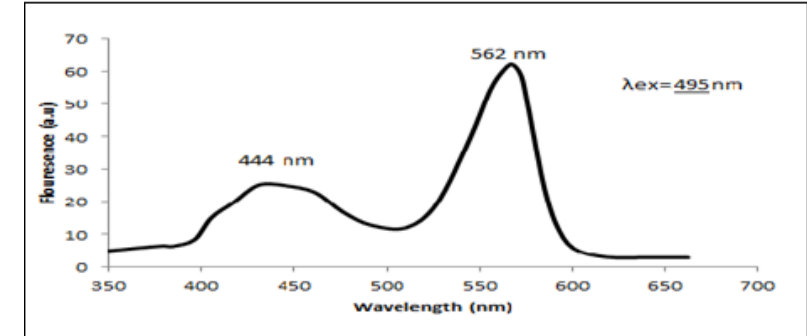
Fig.3: The FL spectrum of the colloidal CdSe/CdS nanoparticle